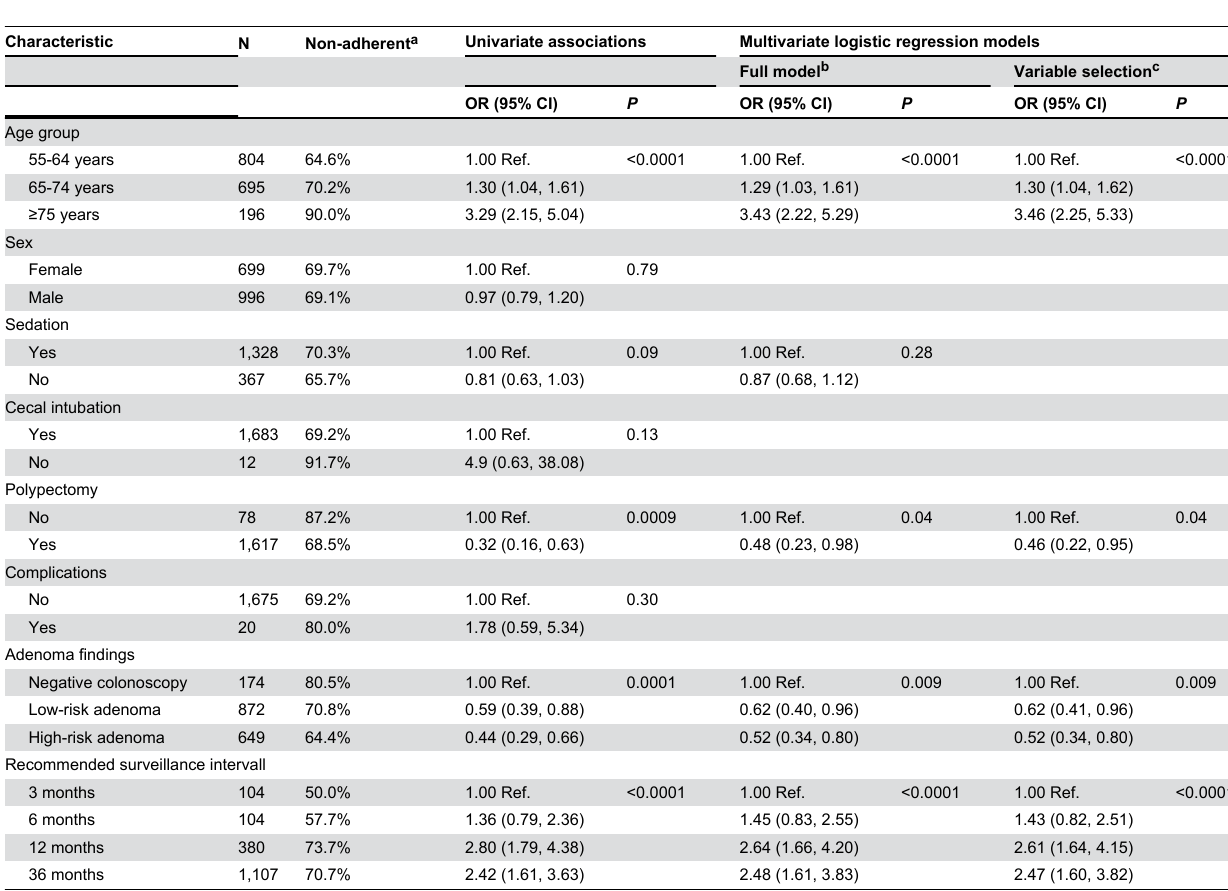
Table 4. Predictors of non-adherence to physician recommendations for surveillance colonoscopy.